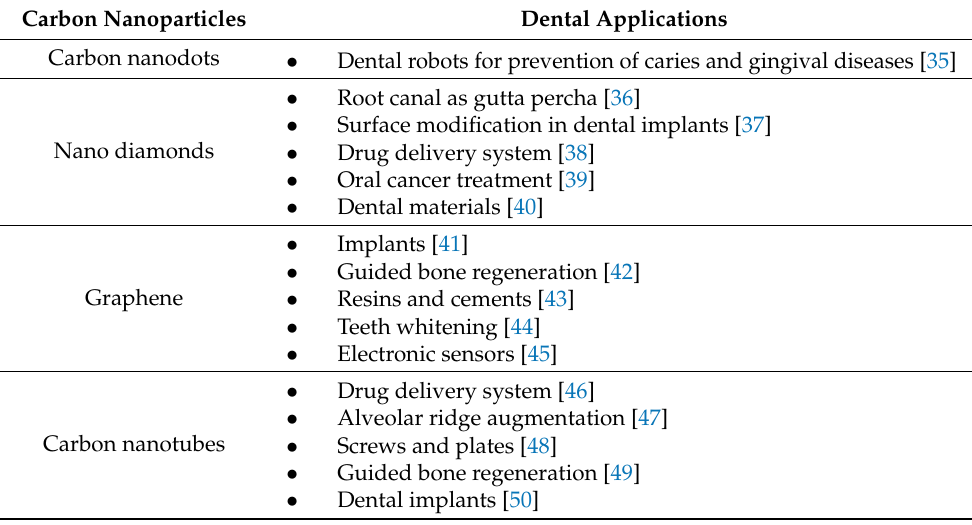
Table 1. Application of carbon nanoparticles in